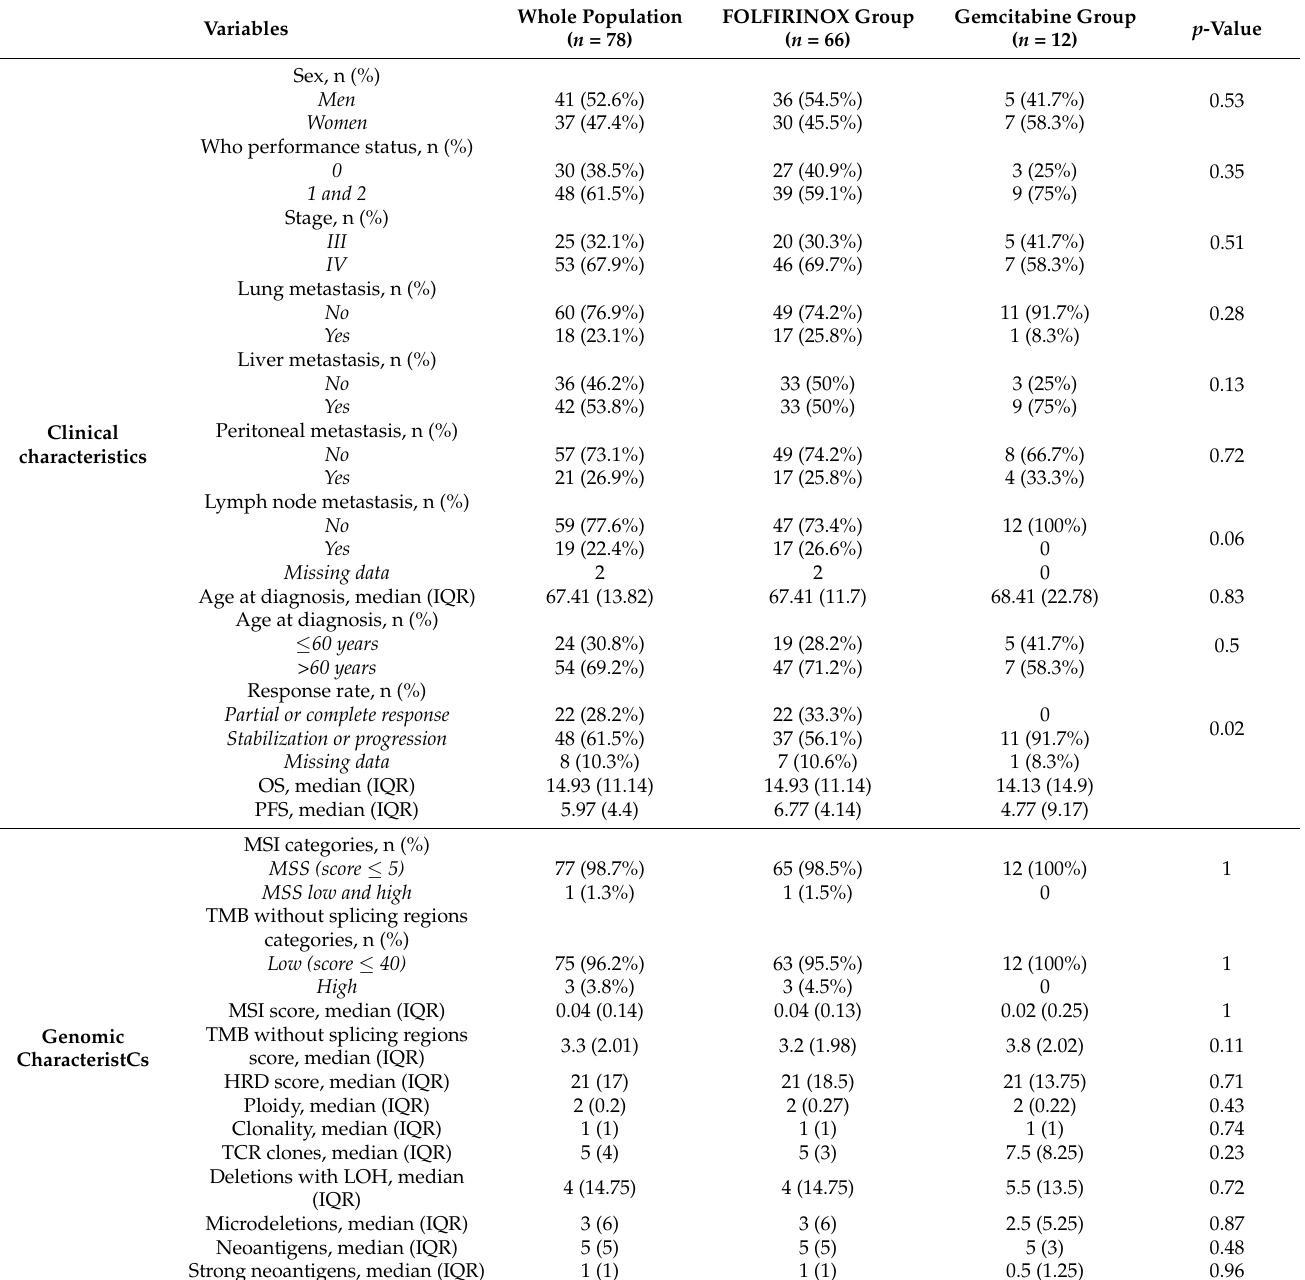
Table 1. Summary of clinical and genomic characteristics of 78 patients with locally advanced or metastatic pancreatic ductal adenocarcinoma cancer (PDAC) who underwent whole exome sequencing